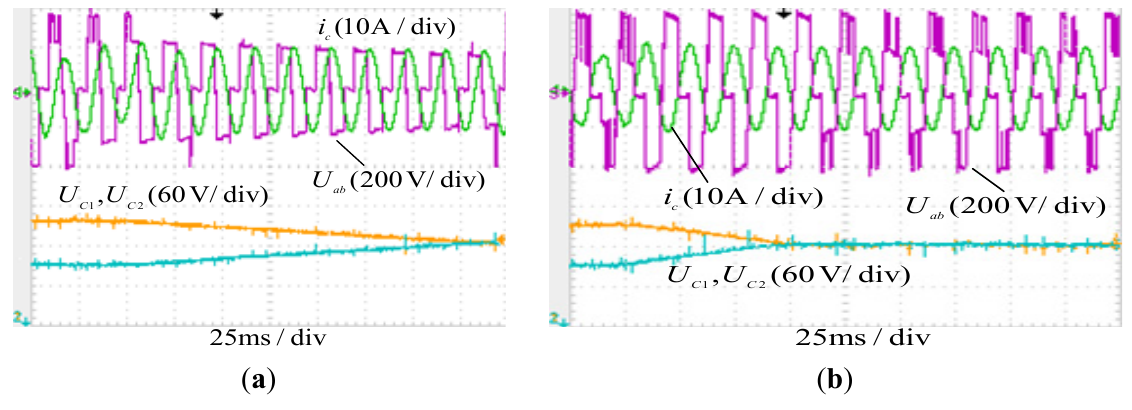
Figure 6. Experiment results of balancing the capacitors voltage: ( a ) VSVM; ( b )